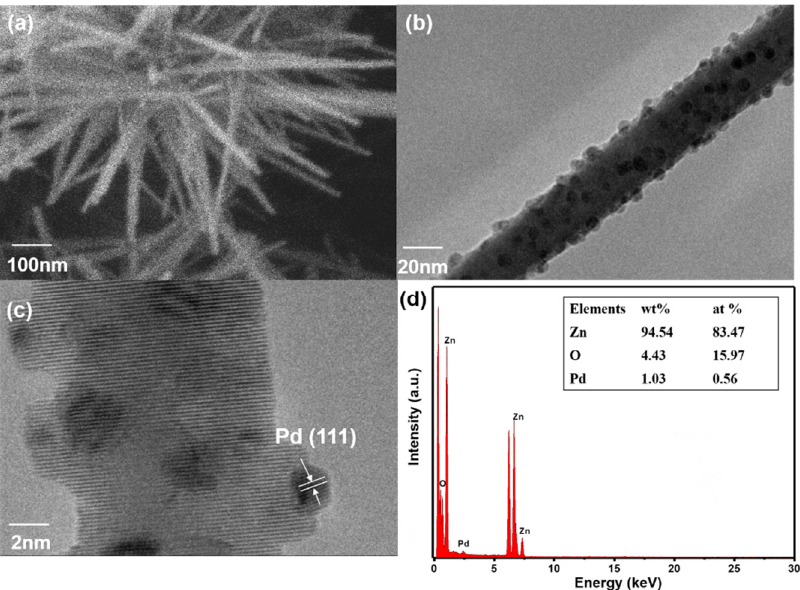
Figure 2. SEM images of ( a ) ZnO-1.0Ba/Pd, ( b ) TEM of ZnO-1.0Ba/Pd, ( c ) HRTEM image of ZnO- 1.0Ba/Pd, ( d ) EDX spectrum of ZnO-1.0Ba/Pd.